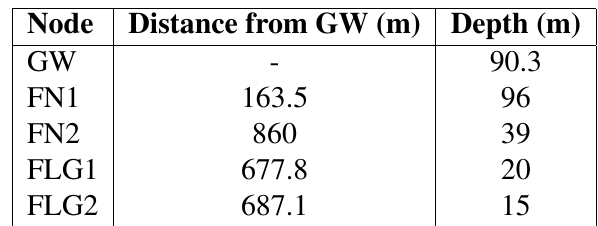
Table 1. Configuration parameters for Scenario